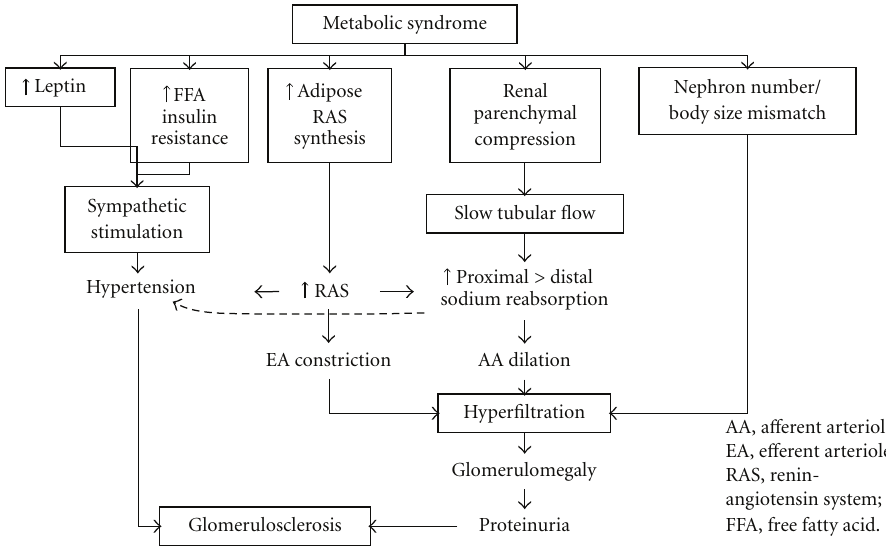
Figure 1: Hemodynamic consequences of obesity leading to hyperfiltration and